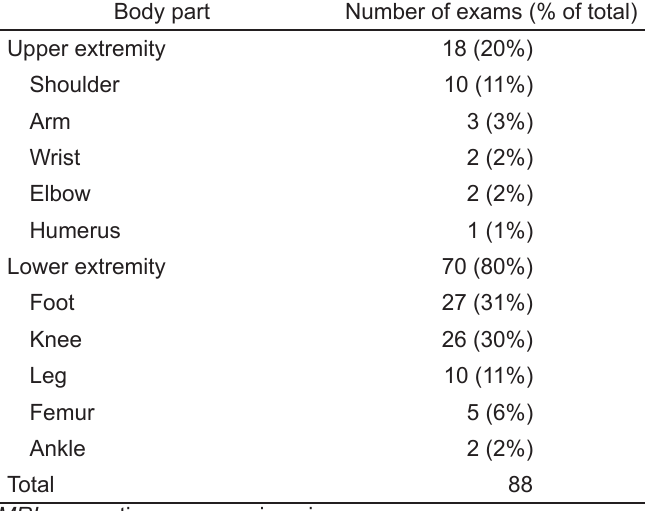
MRI, magnetic resonance